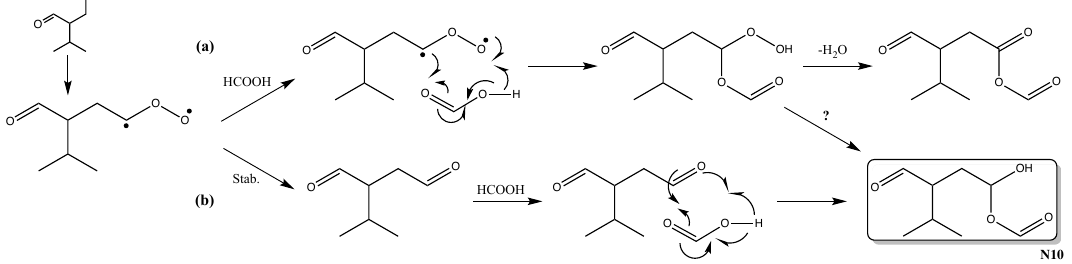
Figure 10. Reaction of (a) prominent second-generation CI with formic acid and (b) accretion of major second-generation carbonyl with formic acid to yield proposed structure for compound N10. An unknown channel is required to join pathway (a) with product N10.